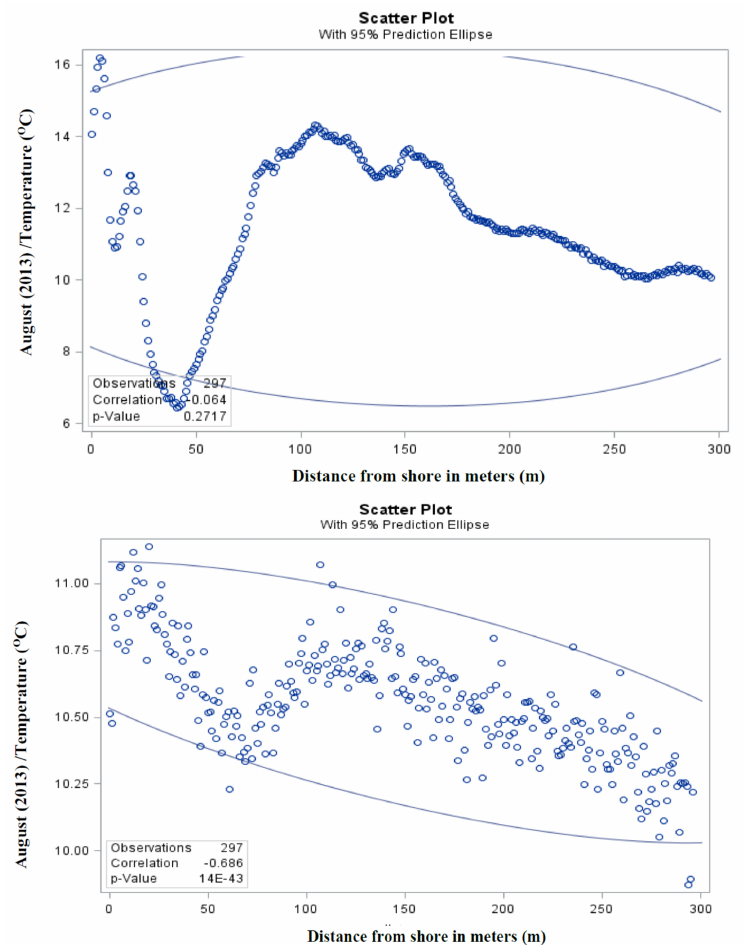
Figure 5. Plot showing Pearson’s correlations between August 2013 temperature and distance at Suvilahti, in the city of Vaasa. Ketunkatu (above) and Liito-oravankatu (below). The meaning of p -value = 14E − 43 = 14 × 10 − 43